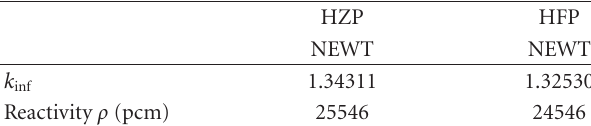
Table 6: Kozloduy-6 fuel pin—NEWT results for reference model.